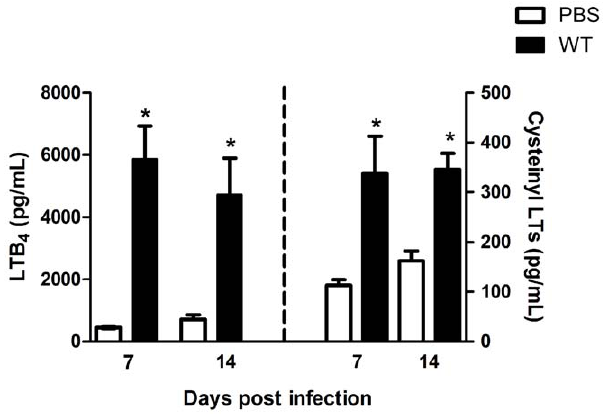
Figure 1. LTB 4 and CysLTs production in lung tissue. Enzyme immunoassay quantification of LTB 4 and CysLTs concentrations in lungs from mice that had received either an i.t. PBS injection (uninfected) or an i.t. infection with H. capsulatum . Data are presented as the mean 6 SEM and are representative of one of two independent experiments (n=6). *, p , 0.05 vs.